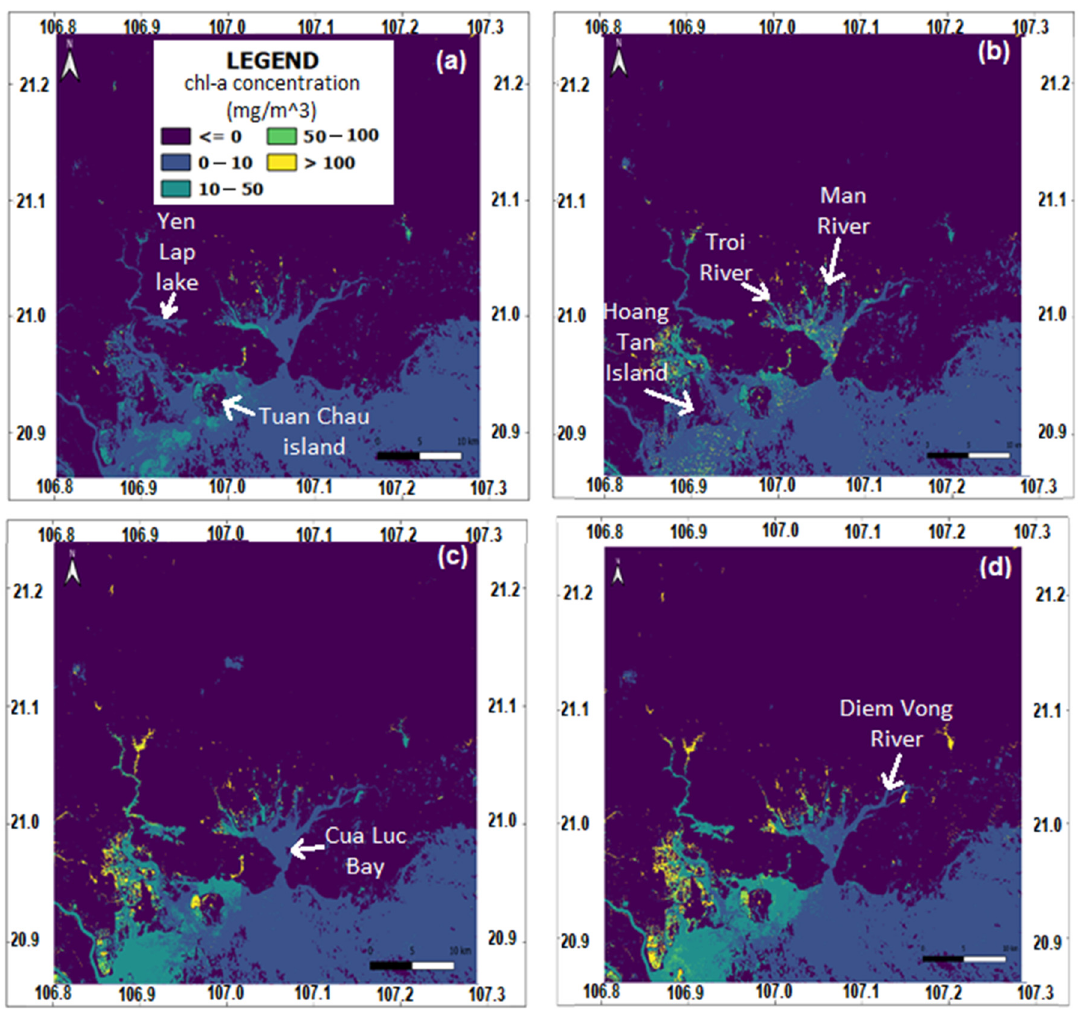
Figure 5. Distribution of chl-a concentration (mg/m 3 ) retrieved from Sentinel-2 using the OC-2 algorithm in Ha Long Bay in 2019 in ( a ) spring, ( b ) summer, ( c ) fall, and ( d ) winter.